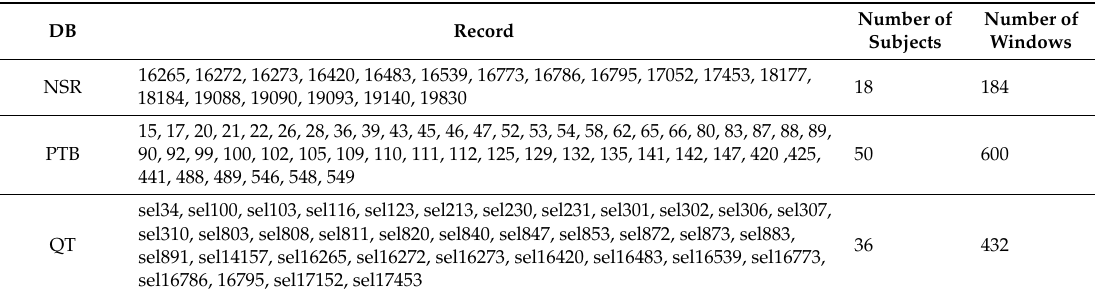
Table 1. Experimental setting. DB: database; NSR: normal sinus rhythm; PTB: ptb diagnostic; QT: qt